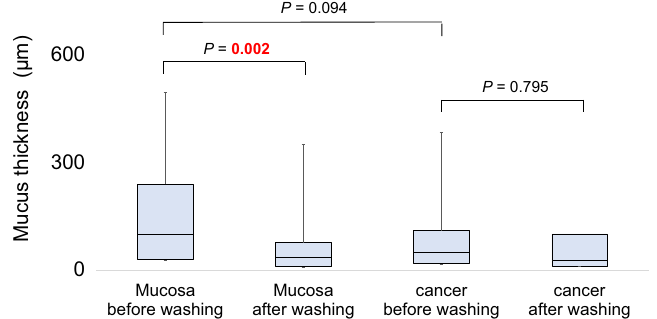
Figure 1. Comparisons of the thickness of the mucus covering the mucosa before and after washing, and of the mucus covering cancer tissue before and after washing by boxplot. Whiskers are extended to the most extreme data point, which is no greater than 1.5 × the interquartile range from the edge of the box in the boxplot. Statistical significance was determined using the Wilcoxon signed-rank